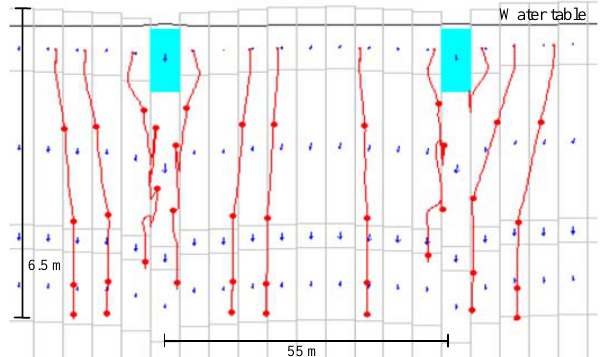
55 m Fig. 11 Steady pathlines for downward flow for the homogeneous case (a) lines are pathlines; each dot represents one year (b) blue boxes are ditches (c) blue arrows are velocity Fig. 12. Transient pathlines for downward flow for the heteroge- Fig. 12 Transient pathlines for downward flow for the heterogeneous case vectors indicating direction and magnitude of water movement neous case: (a) flow simulation 2006 to 2010, each dot represents (a) flow simulation 2006 to 2010, each dot represents one year (b) blue boxes are ditches (c) blue arrows are one year; (b) blue boxes are ditches; (c) blue arrows are velocity velocity vectors indicating direction and magnitude of water movement vectors indicating direction and magnitude of water